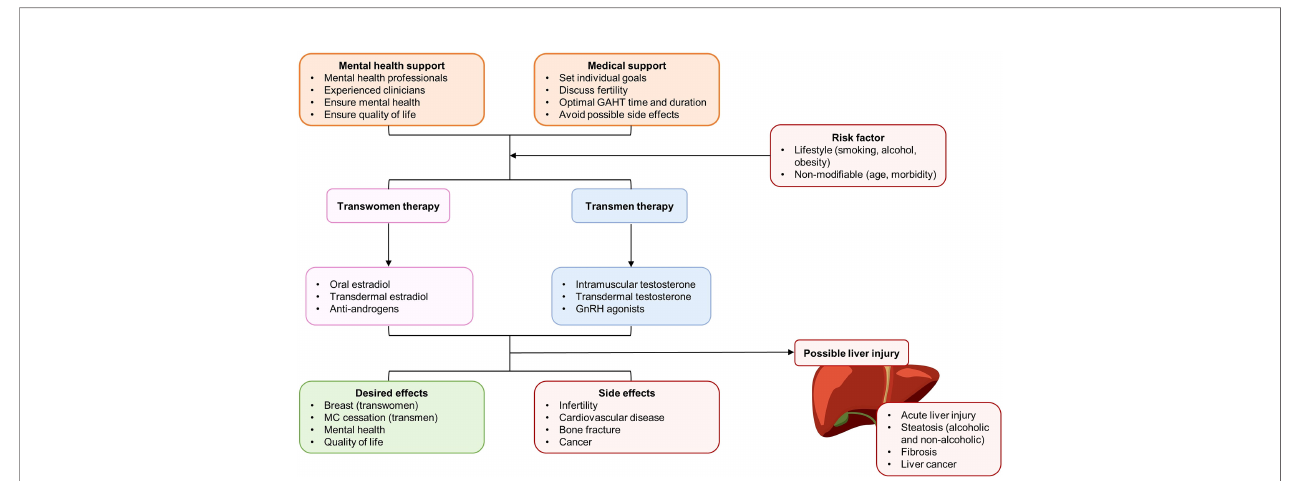
FIGURE 4 | Patient care, therapy selection, and balance between desired effects and potential side effects (with special emphasis in the liver) of gender-af fi rming hormone therapy (GAHT) for transgender populations. AMPK, D2R, dopamine D2 receptor; GnRH, gonadotropin-releasing hormone; MC, menstrual